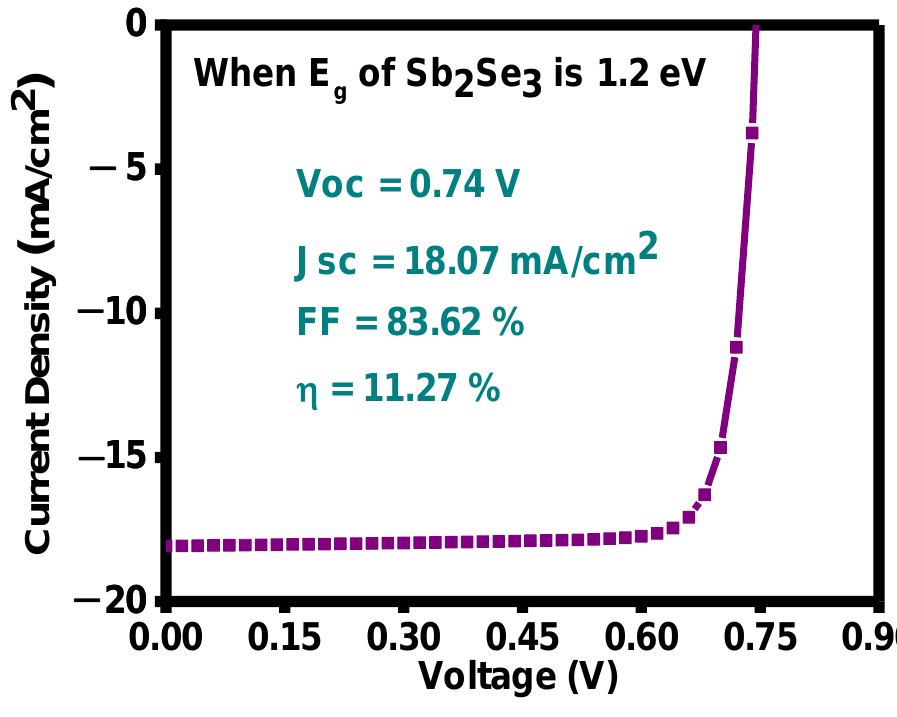
Figure 7. V performance of the optimized solar structure. Table 3. Comparison of Sb 2 Se 3 -/CdS-based solar cells fabricated by various methods.